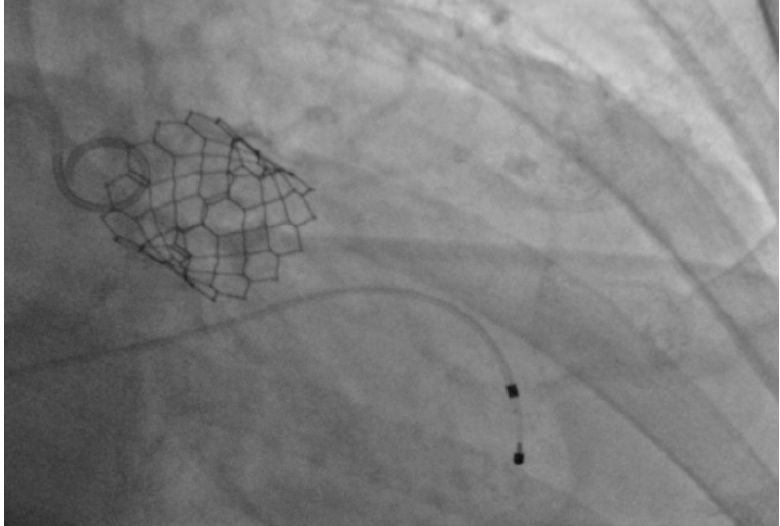
Figure 2. Expanded SAPIEN S3 valve within the native aortic valve.